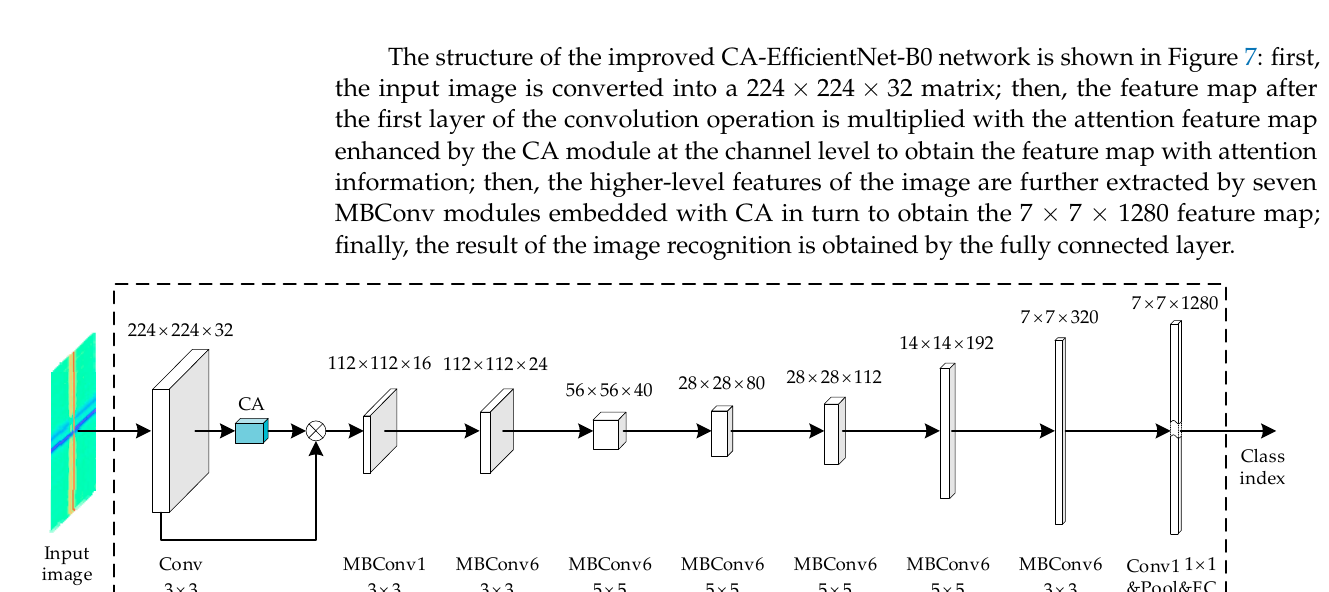
Figure 6. The improved MBConv schematic diagram. Note:  stands for channel ‐ level addition.